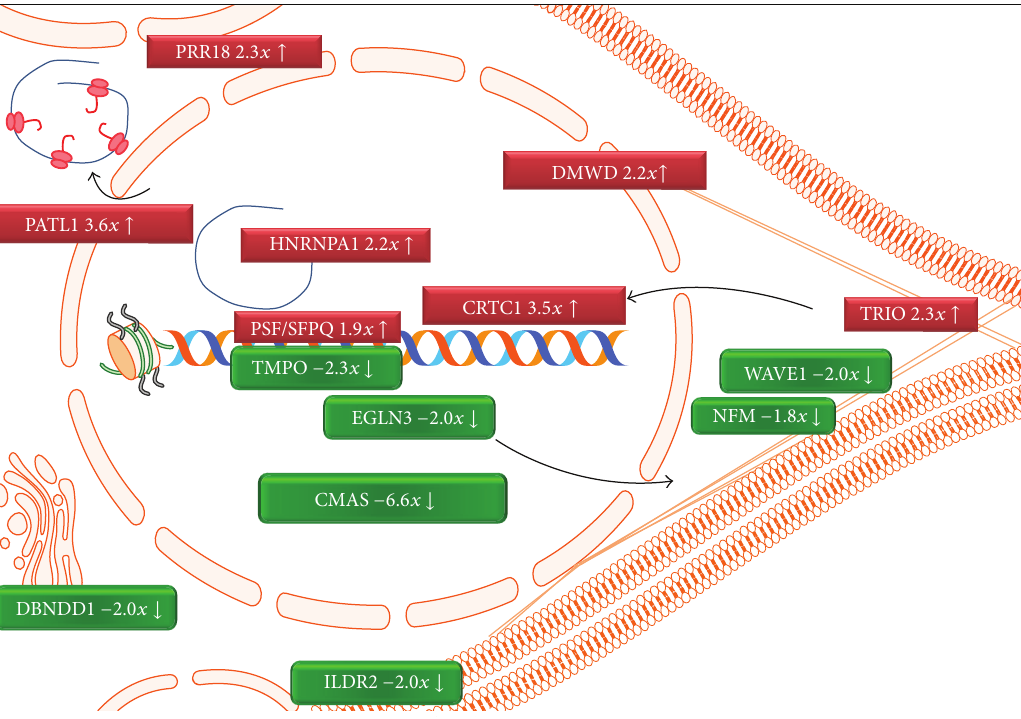
Figure 3: Subcellular localization scheme of proteins with mono-methyl-arginine that show changed abundance. The locations are shown according to GeneCards database information and published literature; diagrams from Motifolio toolkits were used for drawing. Red boxes represent upregulation events; green ellipses were used for downregulations, in sizes proportional to fold changes. Apart from the nuclear envelopearoundDNAandahistoneinthecenterofthepicture,theroughendoplasmicreticulumwithassociatedtranslatingRNAisshownin theupperleftcorner,theGolgiapparatusontheleftside,andthesmoothendoplasmicreticuluminthelowerleftcorner;cytoskeletalelements extend from the right side of the nucleus to the cell membranes, which form a neurite towards the right side and the plasma membrane of an adjacent cell is shown in the lower right corner. Arrows indicate nuclear export and